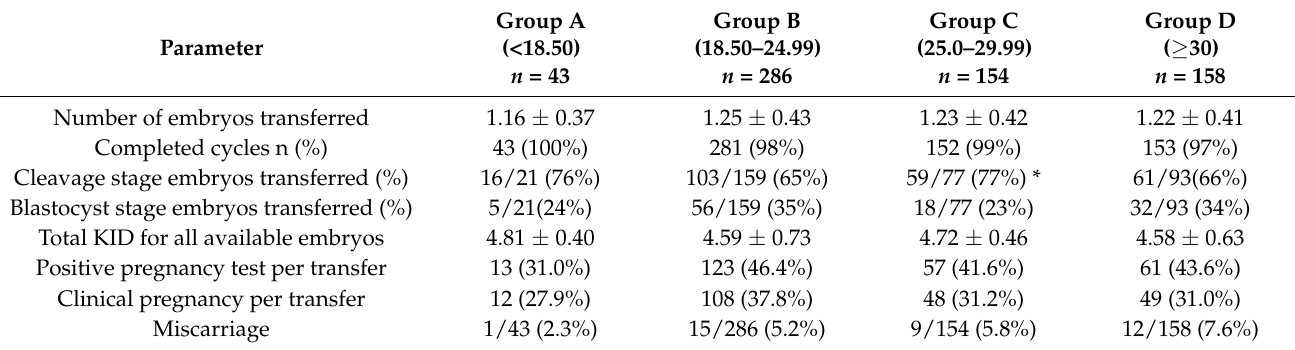
Table 2. Cycle parameters and results based on maternal BMI